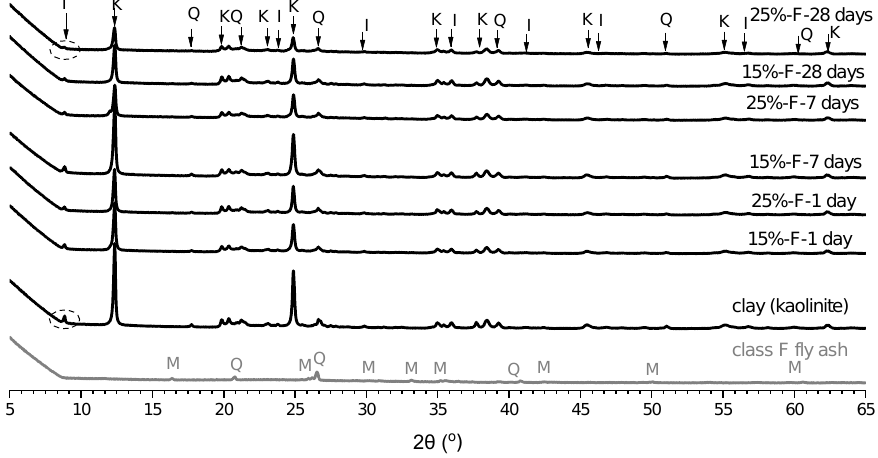
Figure 11. XRD patterns of fly ash, clay, and soils stabilised with 15% and 25% of class F fly ash at 1 day, 7 days, and 28 days of curing; I = illite, K = kaolinite, Q = quartz.